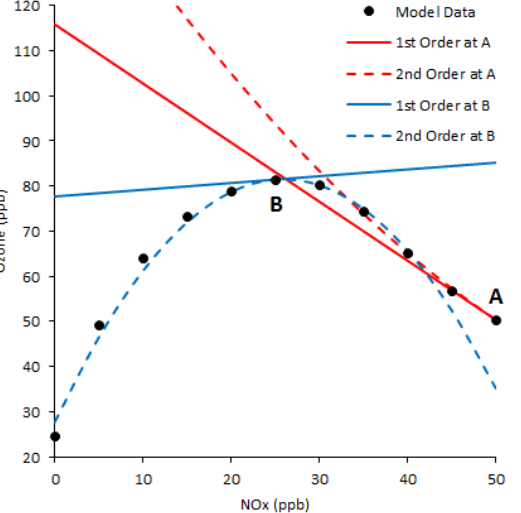
Fig. 2. Modeled response of ozone to changing NO x at VOC of 200ppbC. Also shown are first- and second-order Taylor series ap- proximations to the response at points A and B. Points A and B are also marked in Fig. 1.